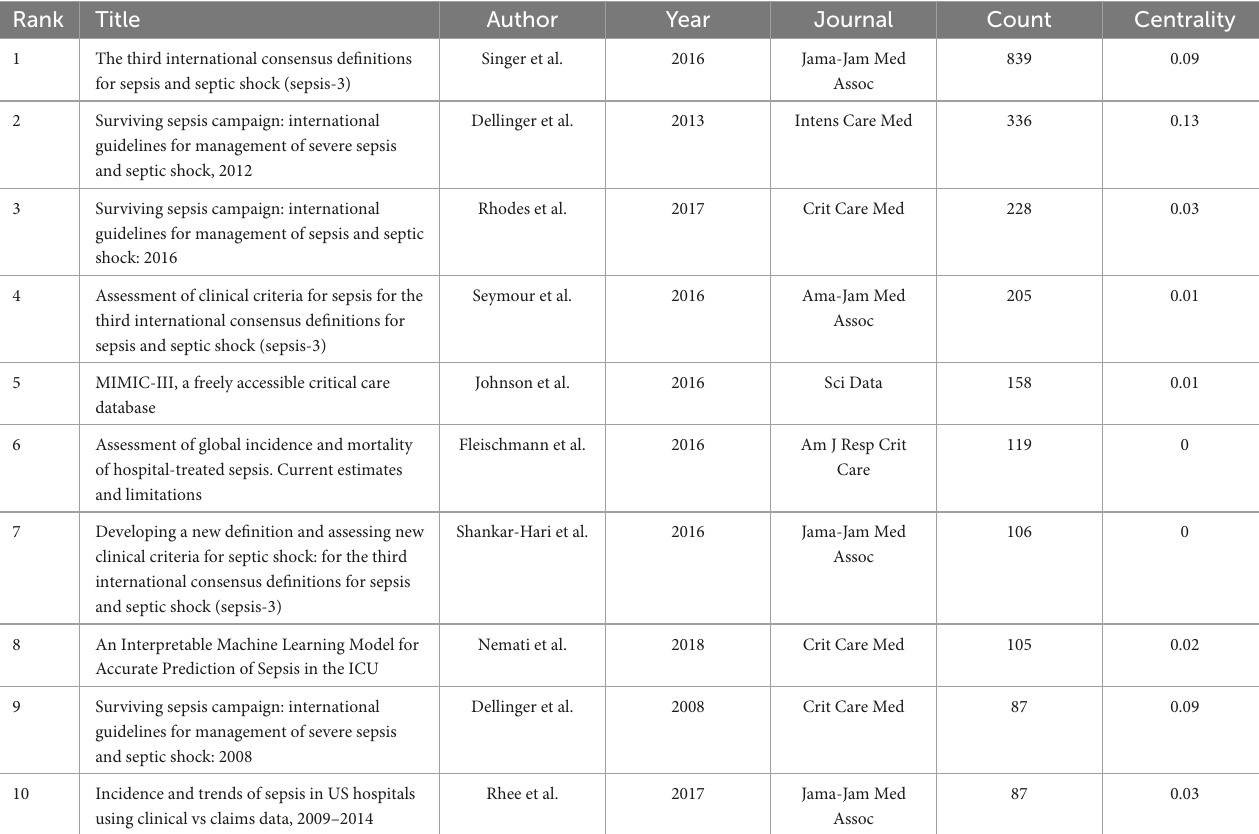
TABLE 4 The top 10 cited references with most publications on the application of artificial intelligence in sepsis from 2000 to